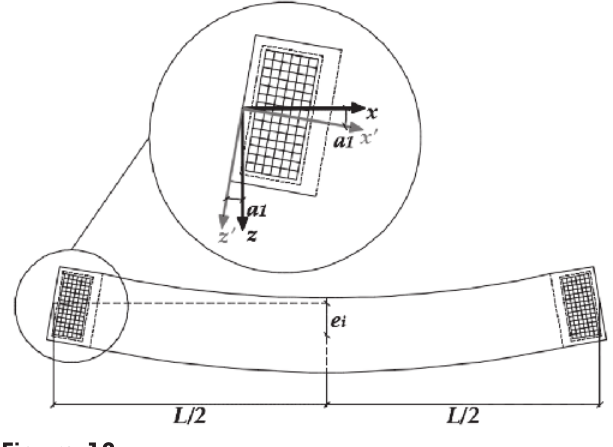
Ângulo inicial na viga com excentricidade lateral inicial